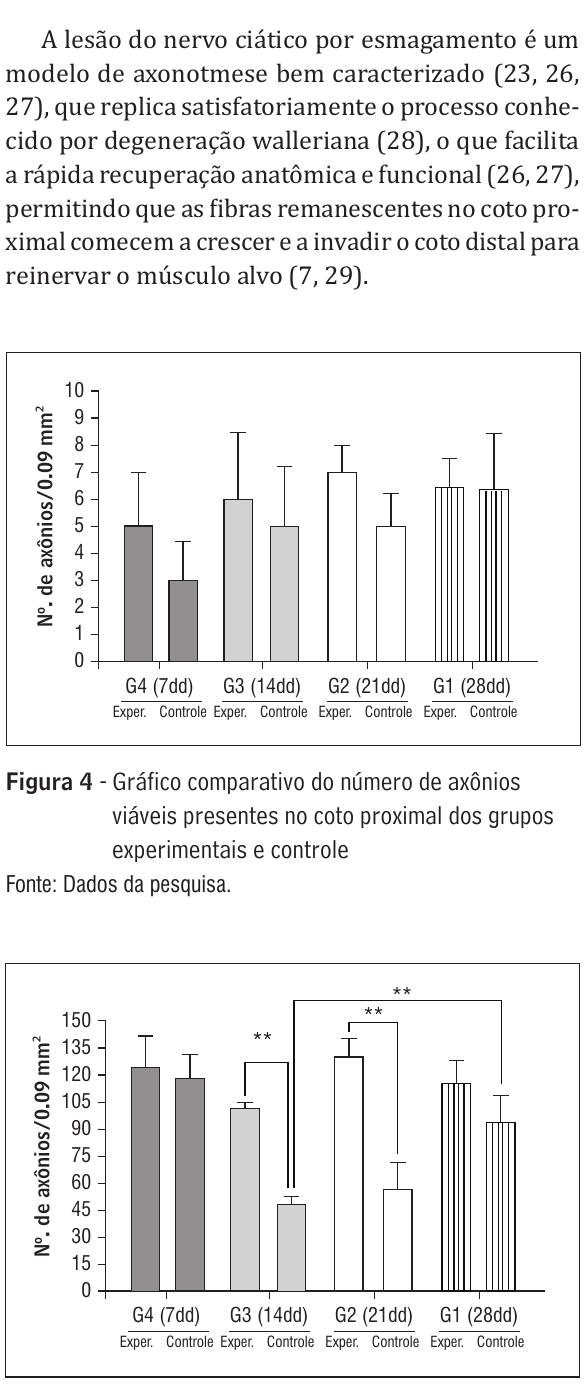
Figura 5 - Gráfico comparativo do número de axônios viáveis presentes no coto distal dos grupos experimentais e